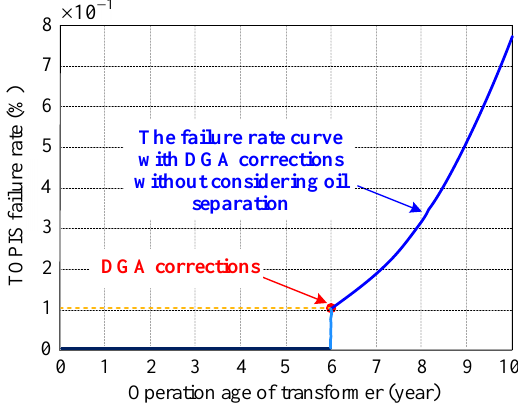
Figure 11. The failure rate curve of TOPIS in its sixth year of operation without considerations of the influences of oil separation. Table 4. The DGA data reference value of transformer when conducting a heavy oil filtering maintenance.